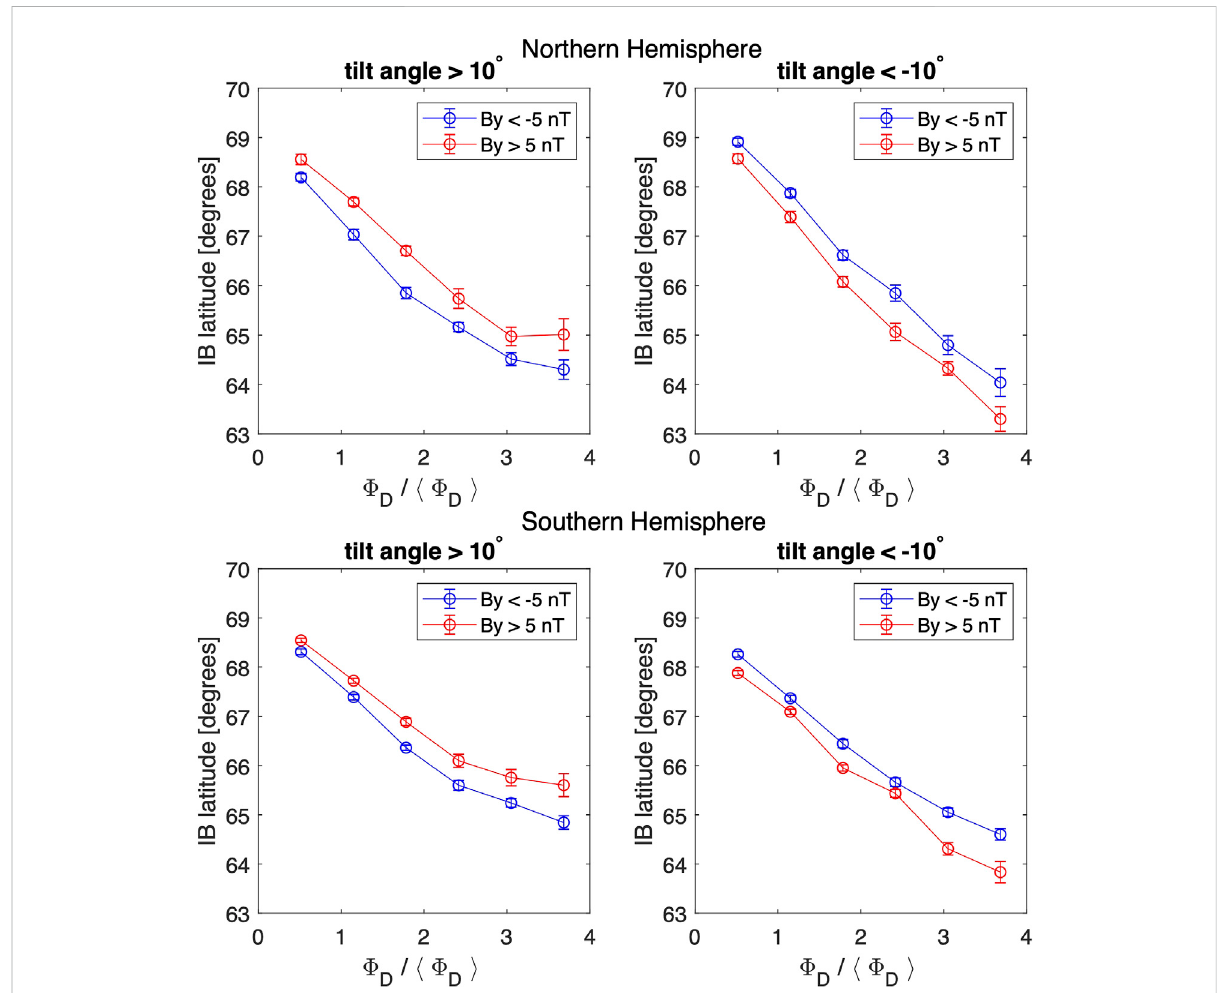
FIGURE 4 Median IB latitude determined from NOAA15-19 satellites in the nightside (18 – 6 MLT) as a function of the normalized Φ D parameter separately for B y > 5 nT and B y < − 5 nT. The error bars indicate ± one standard deviation of the